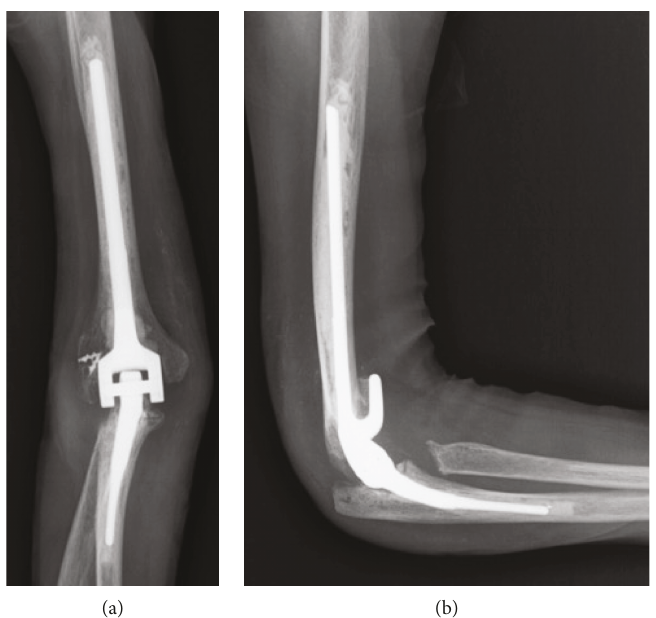
Figure 2: (a) AP and (b) lateral radiographs of the right elbow following a long-stemmed cemented Coonrad-Morrey TEA.